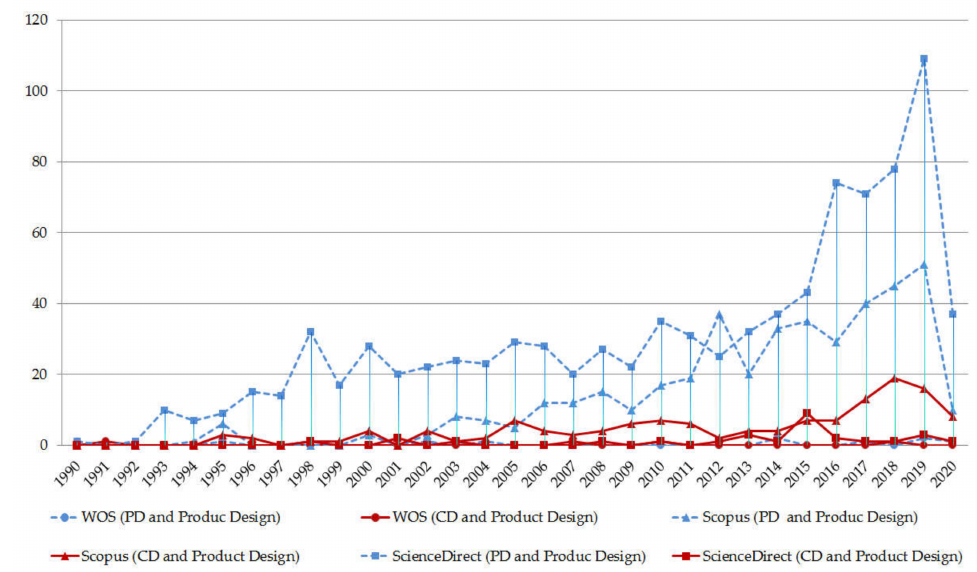
Figure 4. The timeline and number of articles related to product design in participatory design (PD) and co-design (CD)